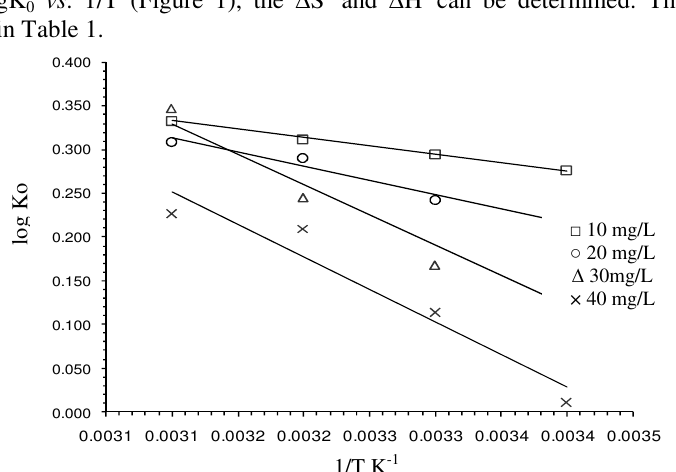
Figure 1. Plot of Van't Hoff equation for adsorption of Cr(VI) on to